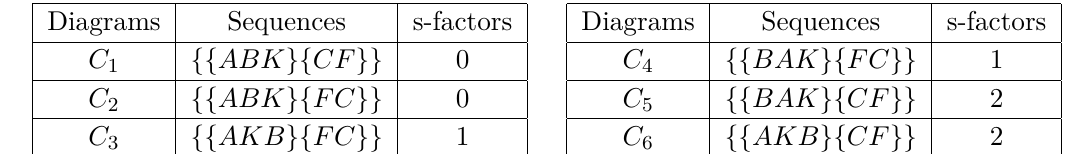
Table 11. Normal ordered diagrams of Cweb W (2 , 1)